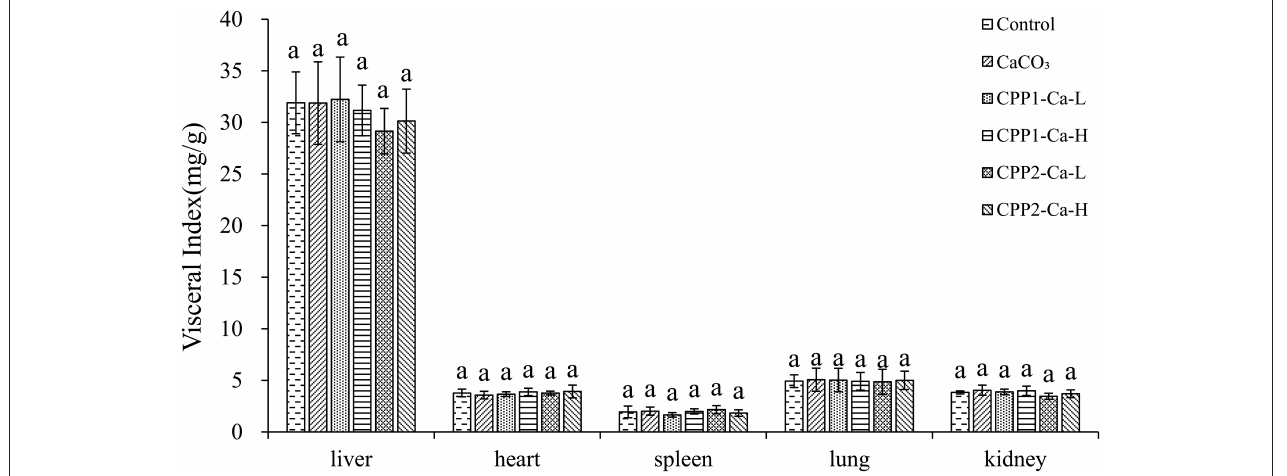
FIGURE 4 | Visceral index of different viscus in different groups. Control group was fed a normal diet, and CaCO 3 group was fed a supplemented calcium diet (1% calcium). CPP1-Ca-L, CPP1-Ca-H, CPP2-Ca-L, and CPP2-Ca-H were fed supplemented calcium with low-dose CPP1 (1% calcium, 0.2% CPP1), high-dose CPP1 (1% calcium, 0.4%), low-dose CPP2 (1% calcium, 0.2% CPP1), high-dose CPP2 (1% calcium, 0.4%), respectively. Different letters indicate statistical difference among the groups at the given time point ( P < 0.05).